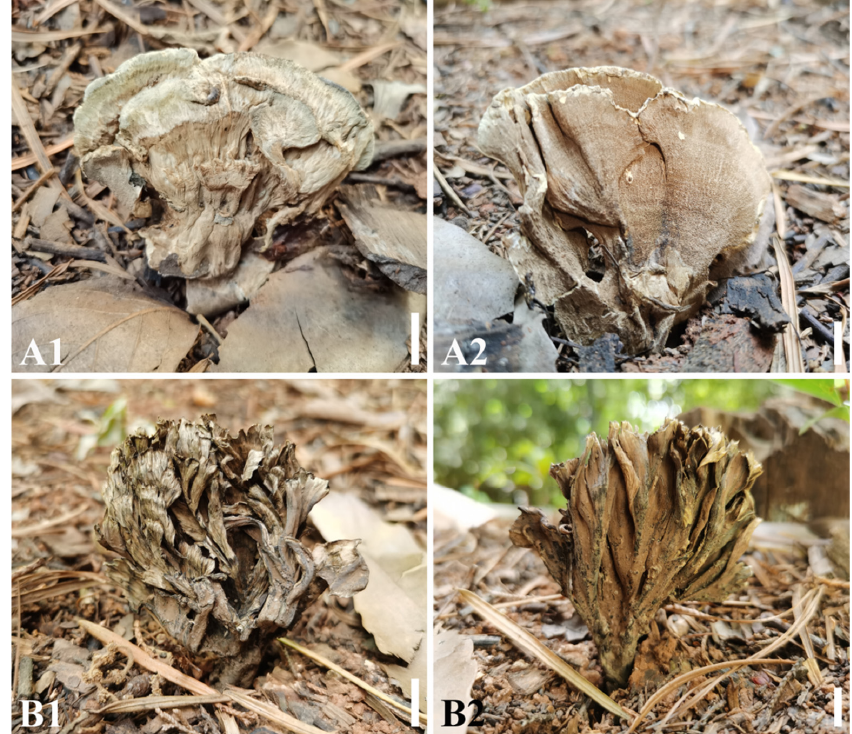
Figure 7. Basidiocarps of Thelephora grandinioides ( A : Holotype CLZhao 3406) and T.